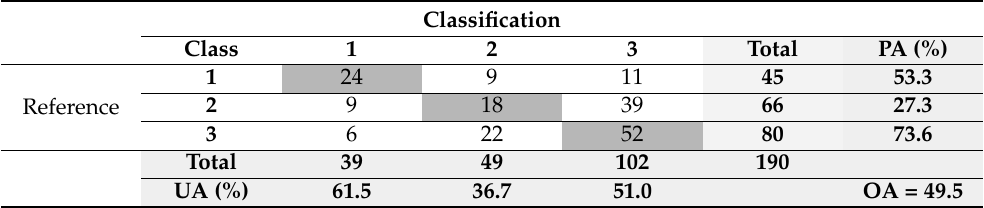
Table 1. Confusion matrix of EBA for NoL calculation, with ALS input data (UA = user accuracy; PA = producer accuracy; OA = overall accuracy). Table 2. Confusion matrix of EBA for NoL calculation, with GEDI input data (UA = user accuracy; PA = producer accuracy; OA = overall